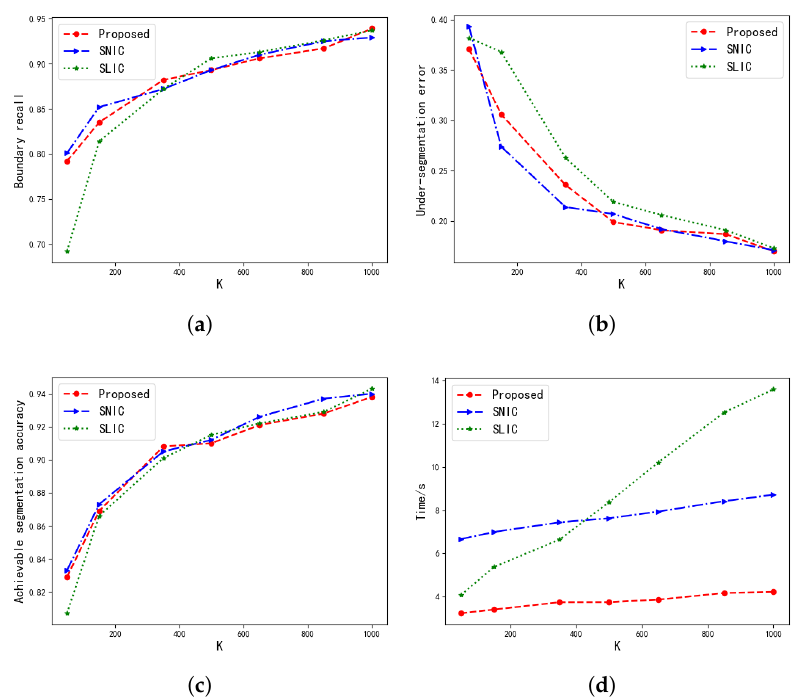
Figure 8. Performance analyzing. As the number of superpixels increases, the performance of the three methods is compared. ( a ) is the boundary recall ( BR ) line chart, ( b ) is the under-segmentation error ( USE ) line chart, ( c ) is the achievable segmentation accuracy (ASA ) line chart, and ( d ) is the line chart representing the time required by the